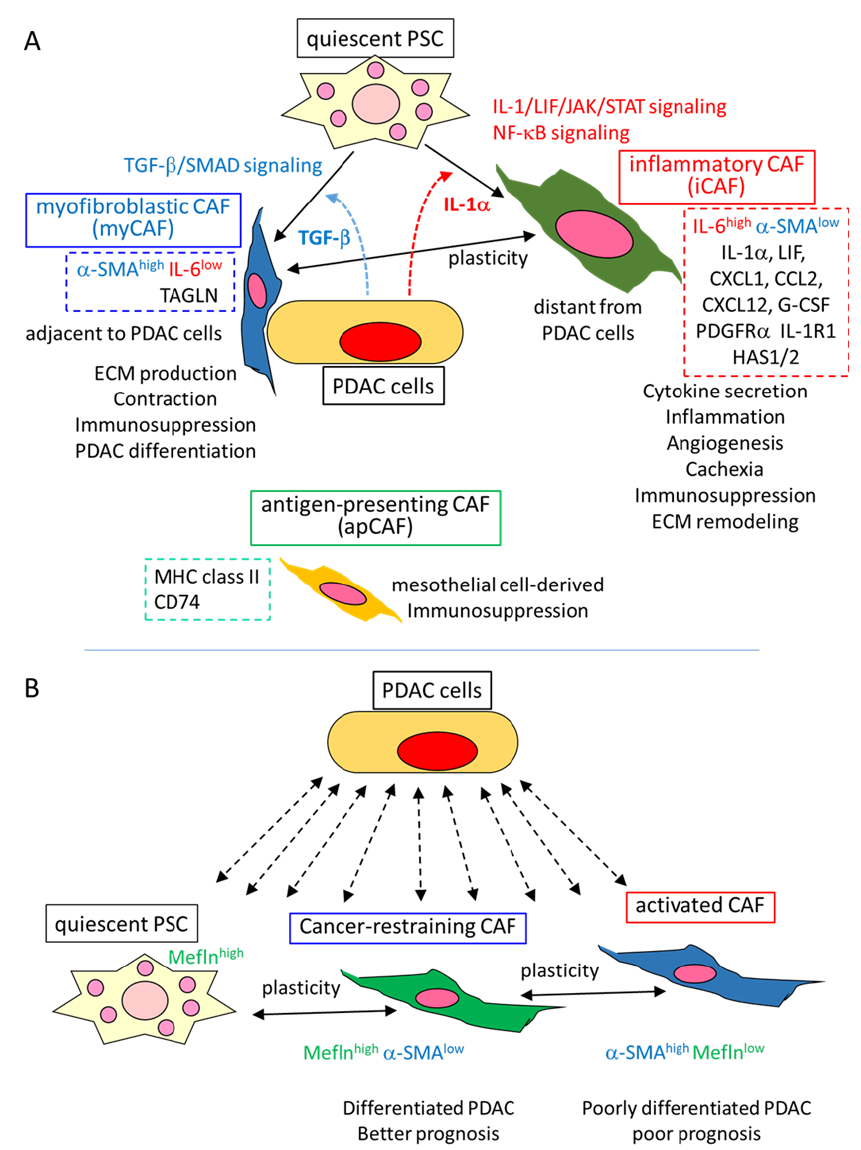
Figure 1. Functional heterogeneity and plasticity of CAFs in PDAC. ( A ) Three CAF clusters identified by Tuveson’s group and their suggested functions [39–41]. Through the interaction with PDAC cells (and others) in the TME, quiescent PSC is converted to two CAF subtypes, depending on distinct signals induced by PDAC cells. Myofibroblastic CAF (myCAF) is induced by TGF- β /SMAD signaling at the location adjacent to PDAC cells. myCAFs express high α -SMA and TAGLN, but low IL-6, and secrete ECM proteins, indicating a myofibroblast-like subtype. Inflammatory CAF (iCAF) is induced by IL-1 α /LIF/JAK/STAT signaling, as well as NF- κ B signaling at a location distant from PDAC cells. iCAFs express high IL-6 and low α -SMA, and also express many kinds of cytokines, as well as PDGFR α , IL-1 α , and HAS1/2, suggesting that iCAFs are involved in inflammation and other TME conditions by secreting those cytokines, as well as in ECM remodeling by HAS1/2. The plasticity is shown between myCAF and iCAF through the balance of the signaling of TGF- β and IL-1 α . Antigen-presenting CAF (apCAF), expressing MHC-II and CD74, is reported to be mesothelial cell-derived. All these subtypes may contribute to an immunosuppressive TME condition. ( B ) Meflin expressing cancer-restraining CAF and plasticity, along with the expression of a-SMA and Meflin, as determined by Mizutani et al. [42]. Through the interaction with PDAC cells (and others) in the TME, quiescent PSC is converted to Meflin high α -SMA low CAF, and subsequently, to α -SMA high Meflin low CAF. CAF subtypes might affect PDAC differentiation and prognosis. Meflin high α -SMA low CAF is reported to be